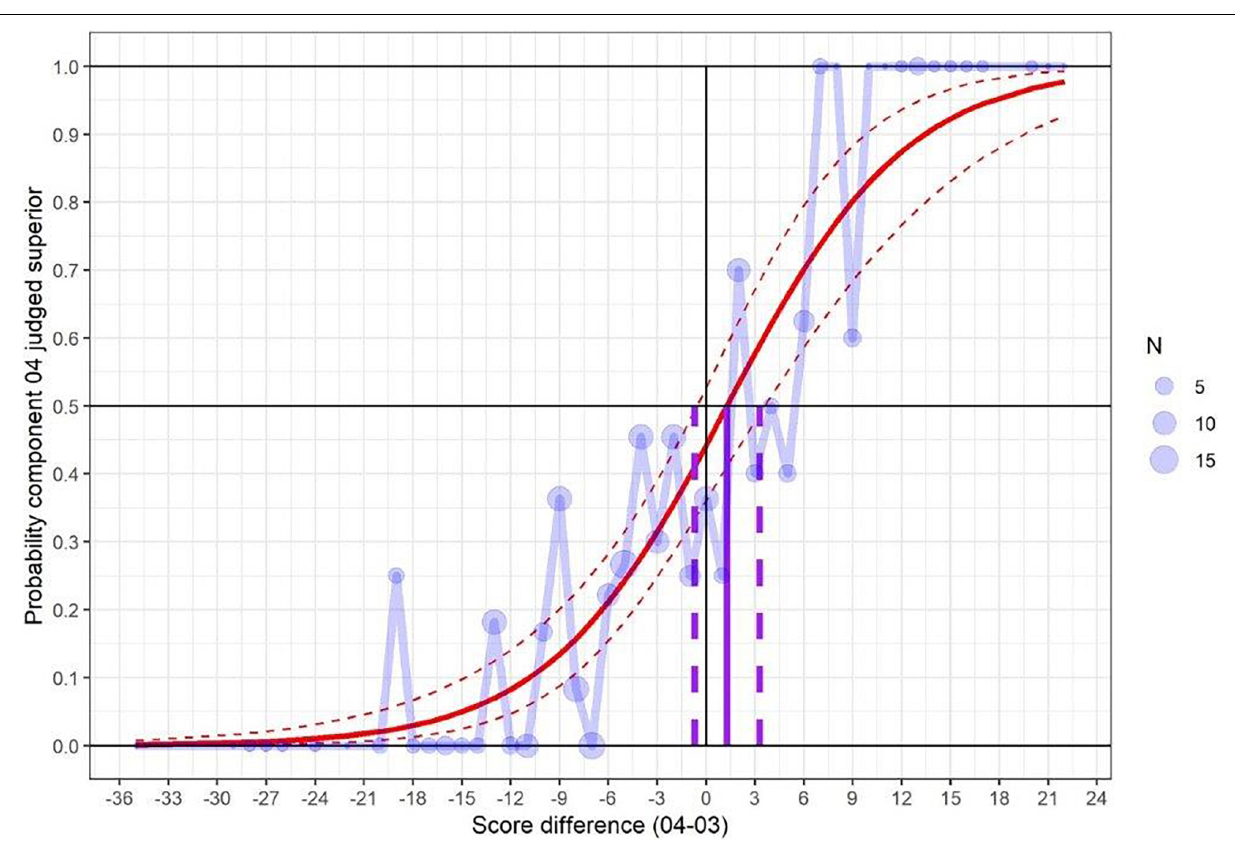
Frontiers in Education |